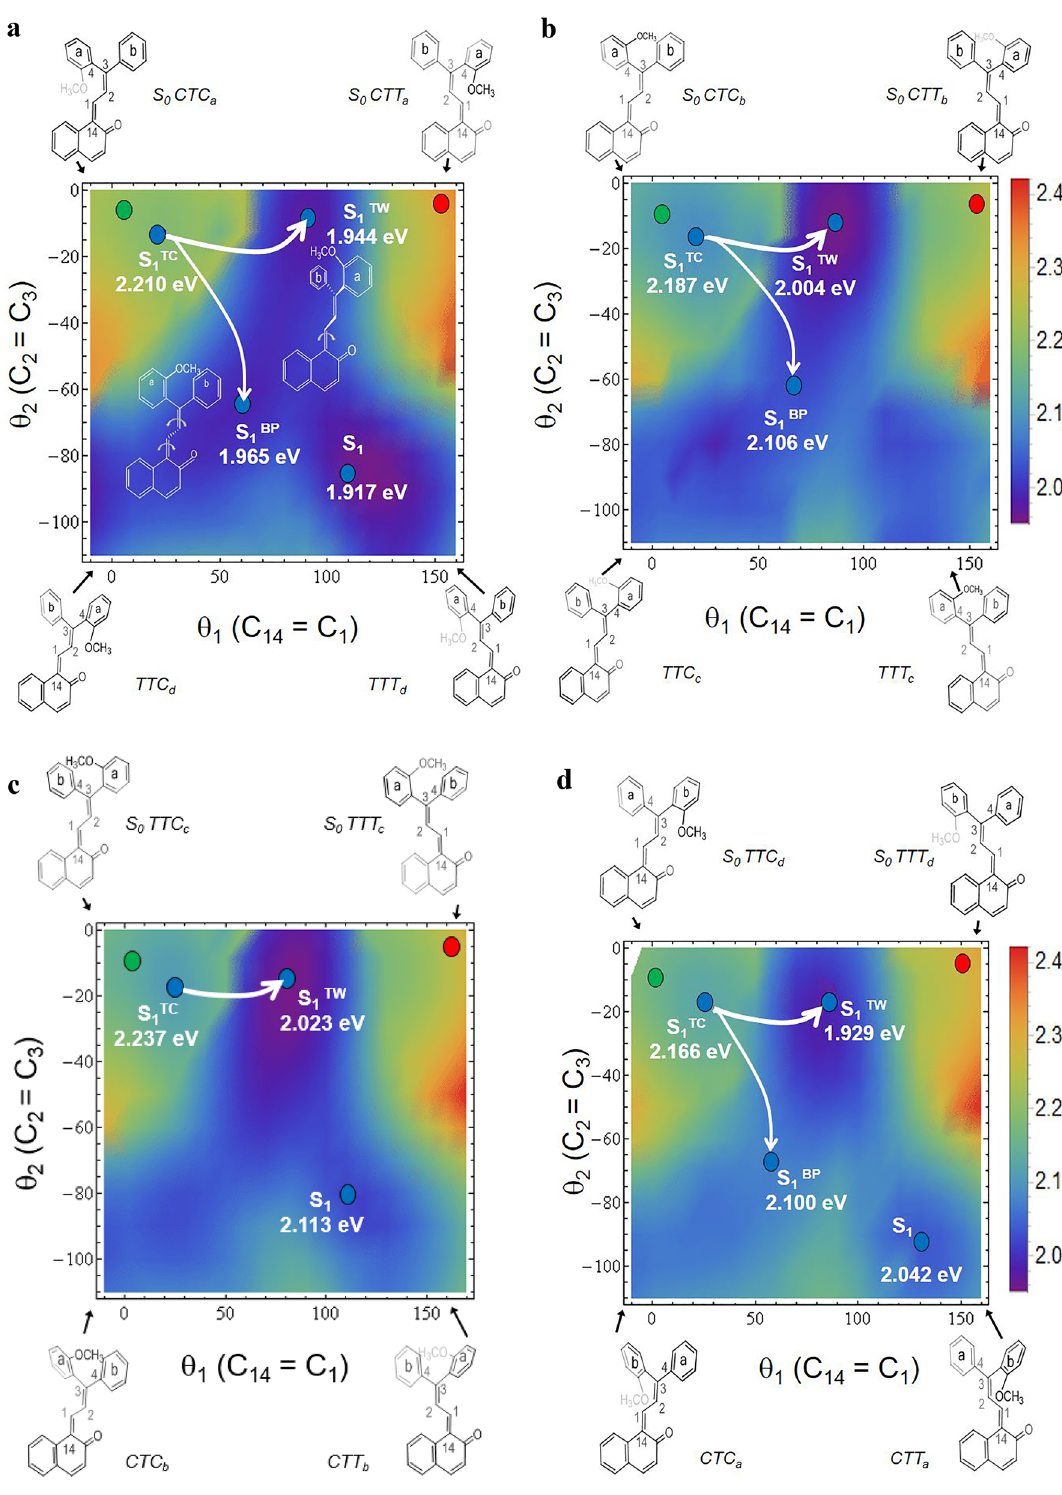
Figure 5. Minimum-potential-energy surface of the lowest excited electronic state of the TC -molecule: ( a ) CTC a , ( b ) CTC b , ( c ) TTC c and ( d ) TTC d , plotted as a function of θ 1 (C 14 =C 1 ) and θ 2 (C 2 =C 3 ) torsional angle coordinates. Green circle represents the Franck–Condon region of the ground-state S 0TC local minimum and red circle represents the ground-state S 0TT local minimum. Blue circles represent various types of the excited-state minima: S 1TC —the minimum initially populated after S 0TC photoexcitation, S 1BP —achieved through the bicycle- pedal motion, and S 1TW —reached by single-twist motion mechanism. The results were obtained with the aid of the ADC(2)/cc-pVDZ method, for the excited state, and with the MP2/cc-pVDZ, for the ground